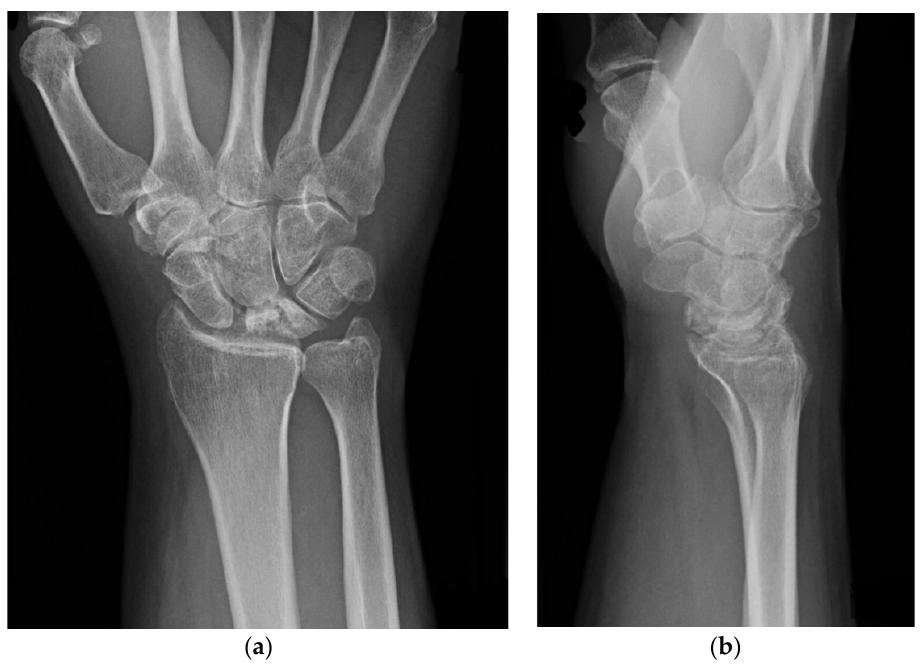
Figure 3. X-ray stage 3B: the collapse of lunate, carpal instability, scaphoid rotation, radioscaphoid angle (RSA) increased. ( a ) Stage 3B, AP view X-ray; ( b ) Stage 3B, lateral view -ray.